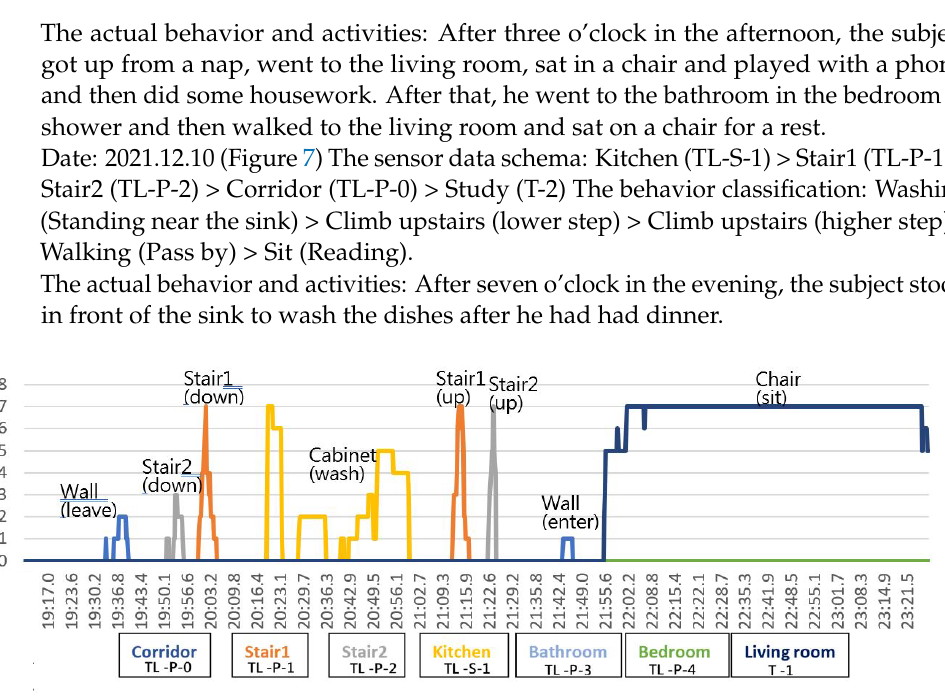
Figure 6. Behavior classification of the accumulated data (8 December 2021).